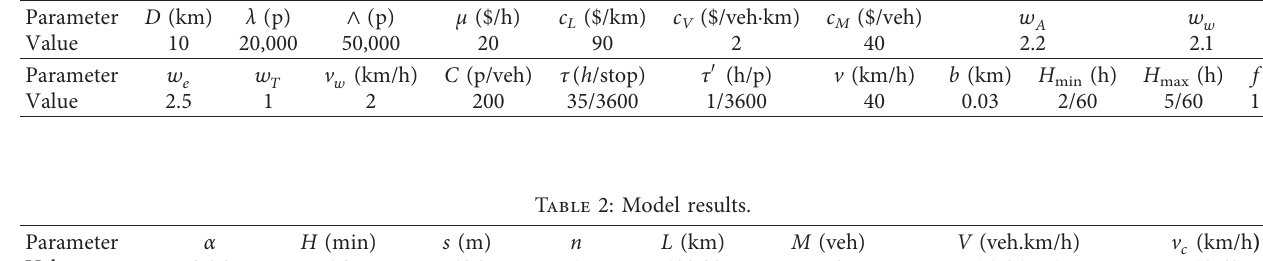
Table 1: Value of model parameters.